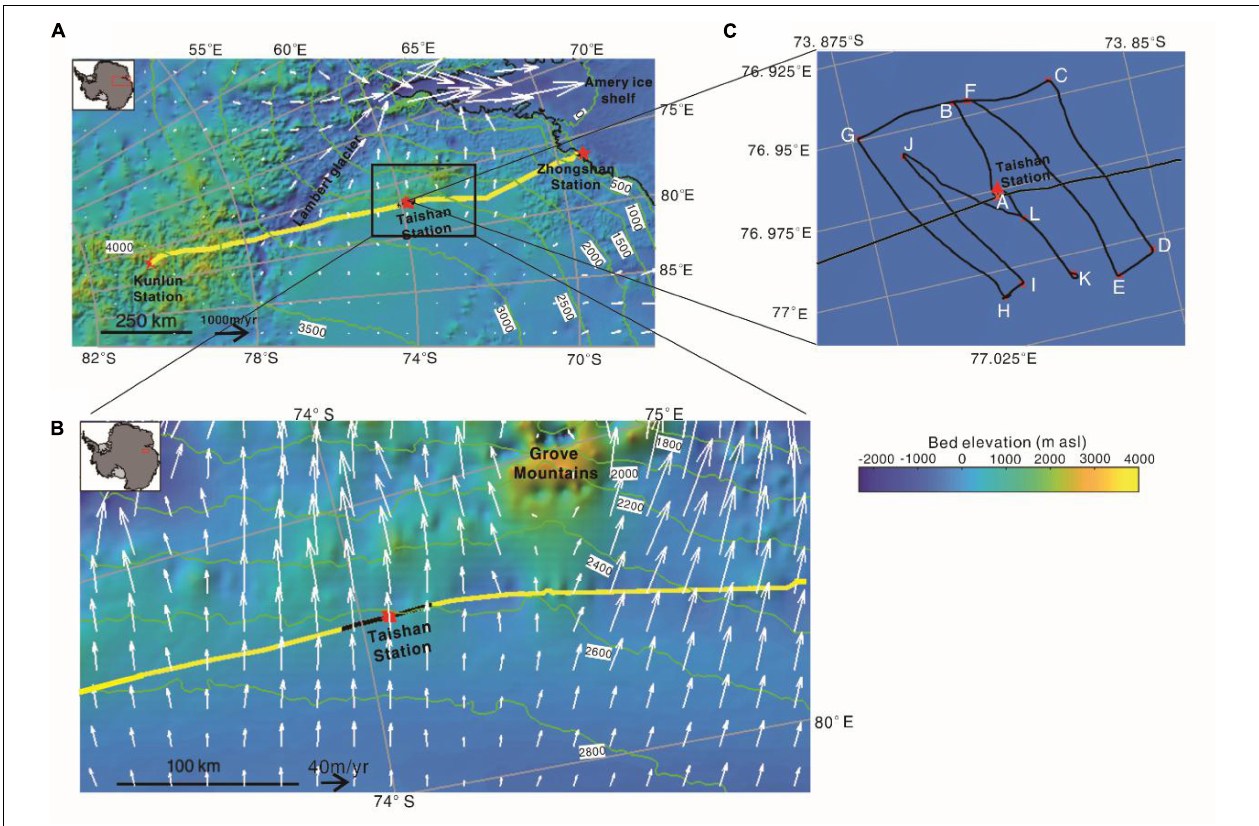
FIGURE 3 | (A) Area map showing the transect routes from Zhongshan to Dome A, East Antarctica. (B) Location of Taishan Station (the red triangle) and orientation of the radar line (black) around the Taishan Station site. (C) Radar profiles in a 2 km × 2 km square area centered on the Taishan Station. The yellow line denotes the radar line from Zhongshan Station to Dome A. Bed elevation (background image), surface elevation (green line), and grounding line (black line) are from Bedmap2 (Fretwell et al., 2013; Tang et al., 2016; Greene et al., 2017). The white arrows represent the vector of the surface ice velocity which was derived from the interferometric synthetic aperture radar (InSAR) data (Rignot et al., 2011; Shepherd et al.,